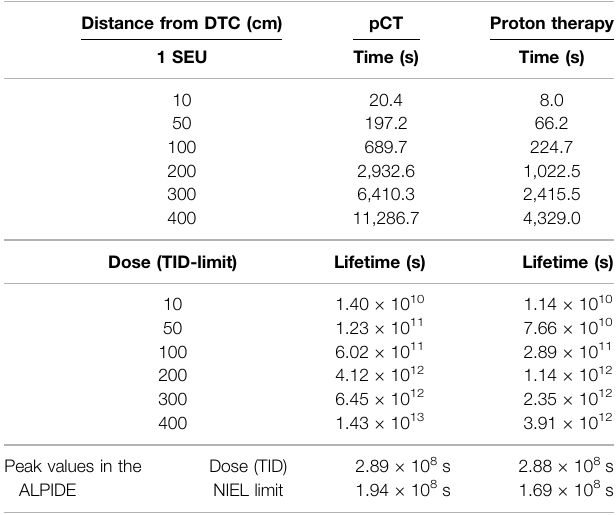
TABLE 1 | Expected FPGA and ALPIDE health and lifetime from being exposed in both pCT and proton therapy.